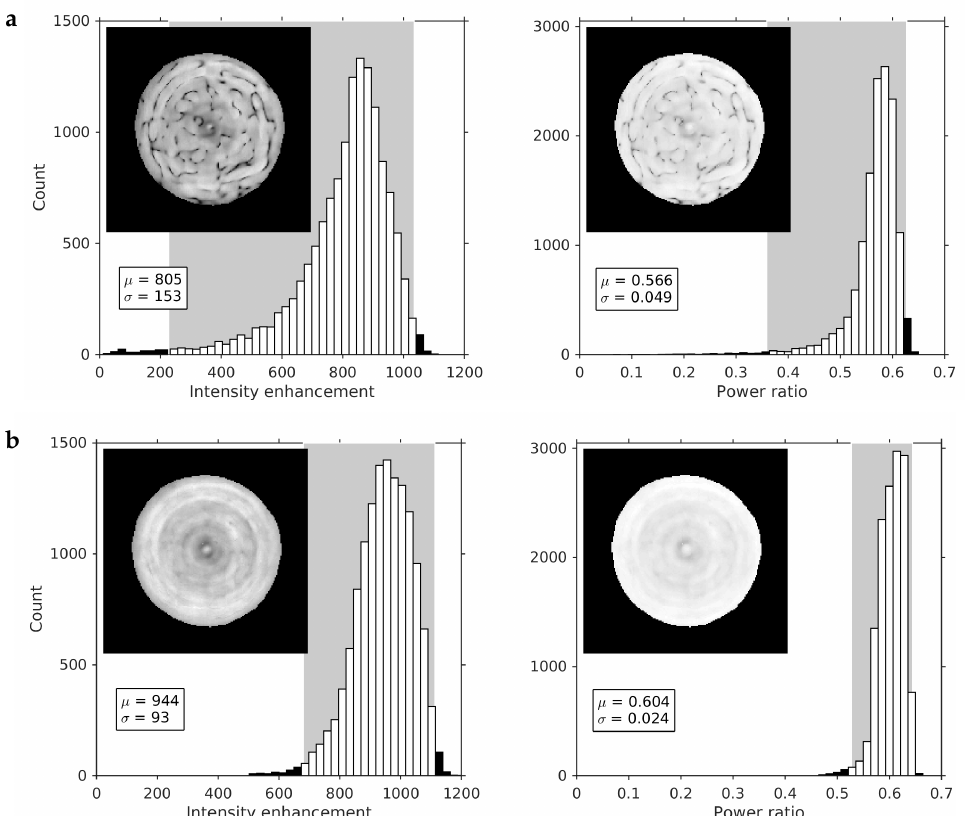
Figure 4. Histograms of intensity enhancement ( left ) and power ratio ( right ) of mode to background expressed, see Equations (6) and (7) for all the output modes. Top-left insets show the maps intensity enhancement or power ratio with their locations on the fibre facet. The transmission matrix was measured with one internal reference, so the blind spots are easily recognised ( a ), and five internal references, where the quality of the output mode is homogeneous over the field of view ( b ). The grey region shows the extent of 99% quantile and both the mean and the standard deviation of the output modes characteristics are denoted in the